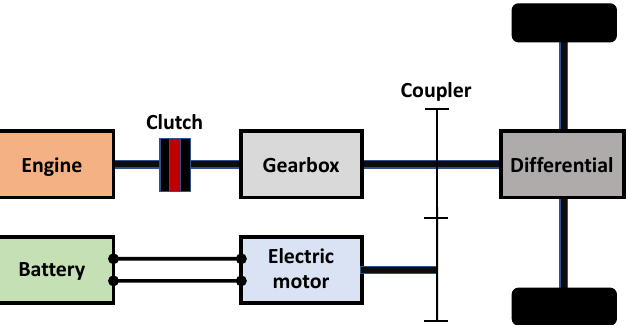
Figure 1. Schematic representation of the considered parallel hybrid electric vehicle (HEV)